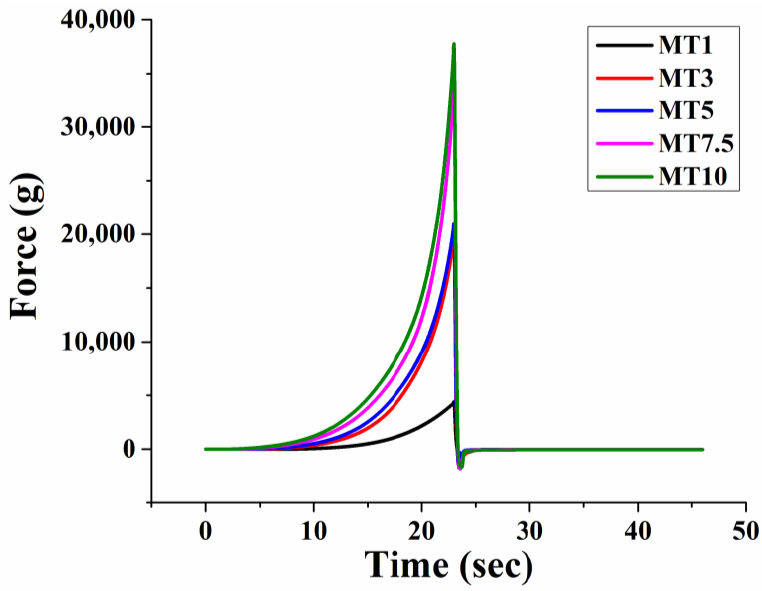
Figure 9. Spreadability profile of cookie dough. Table 2. Parameters obtained from the spreadability test of cookie dough. For each column, different letter(s) indicates significantly different values by the Tukey HSD test. The values were represented as Avg ± Stdev.